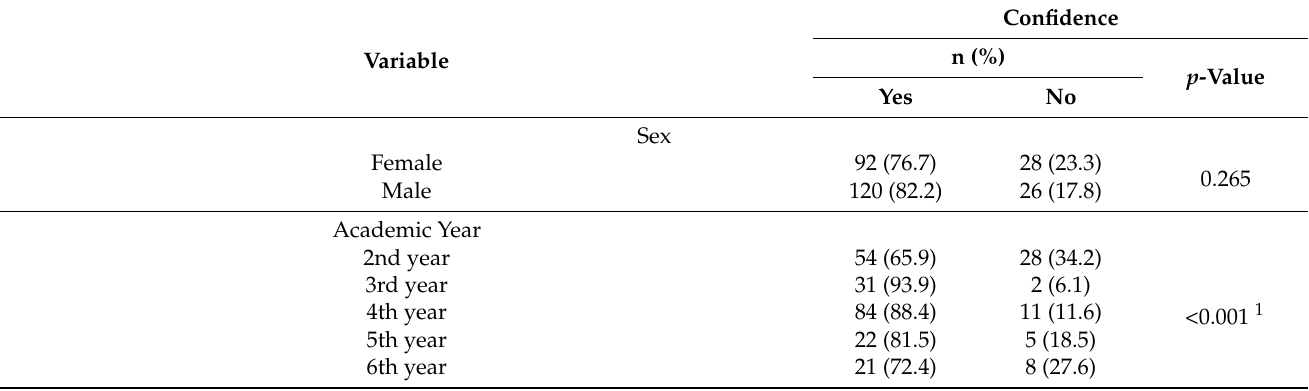
Table 3. Subgroup